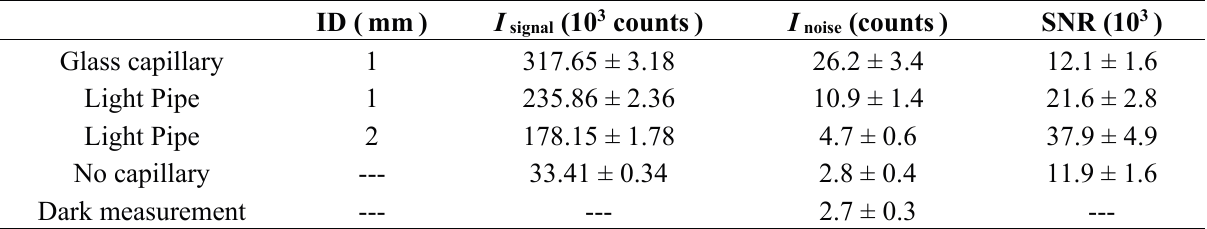
Table 2. Performance of metal-lined glass capillary and metal Light Pipes with different inner diameters ID, in comparison with a 180° Raman measurement without